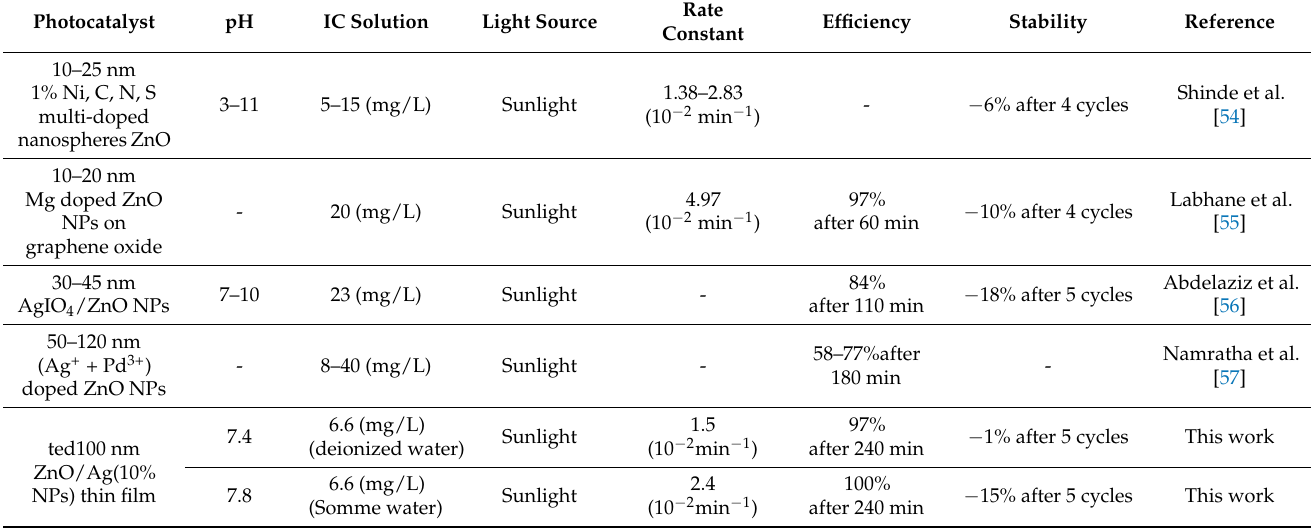
Table 1. Comparison of the results of this study with those of the